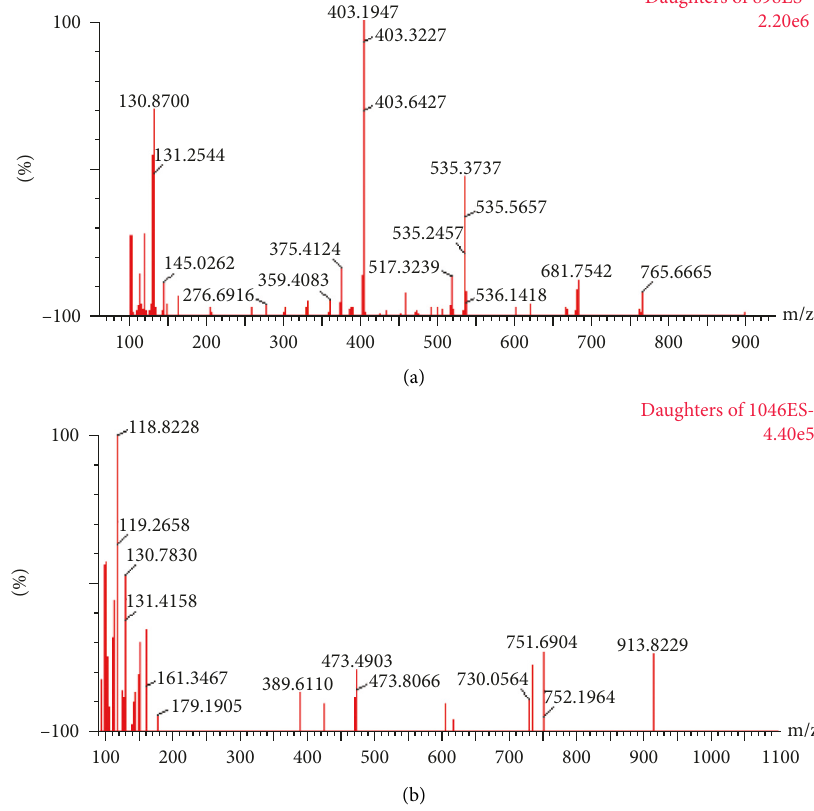
Figure 2: Mass spectra of gypenoside A (a) and gypenoside XLIX